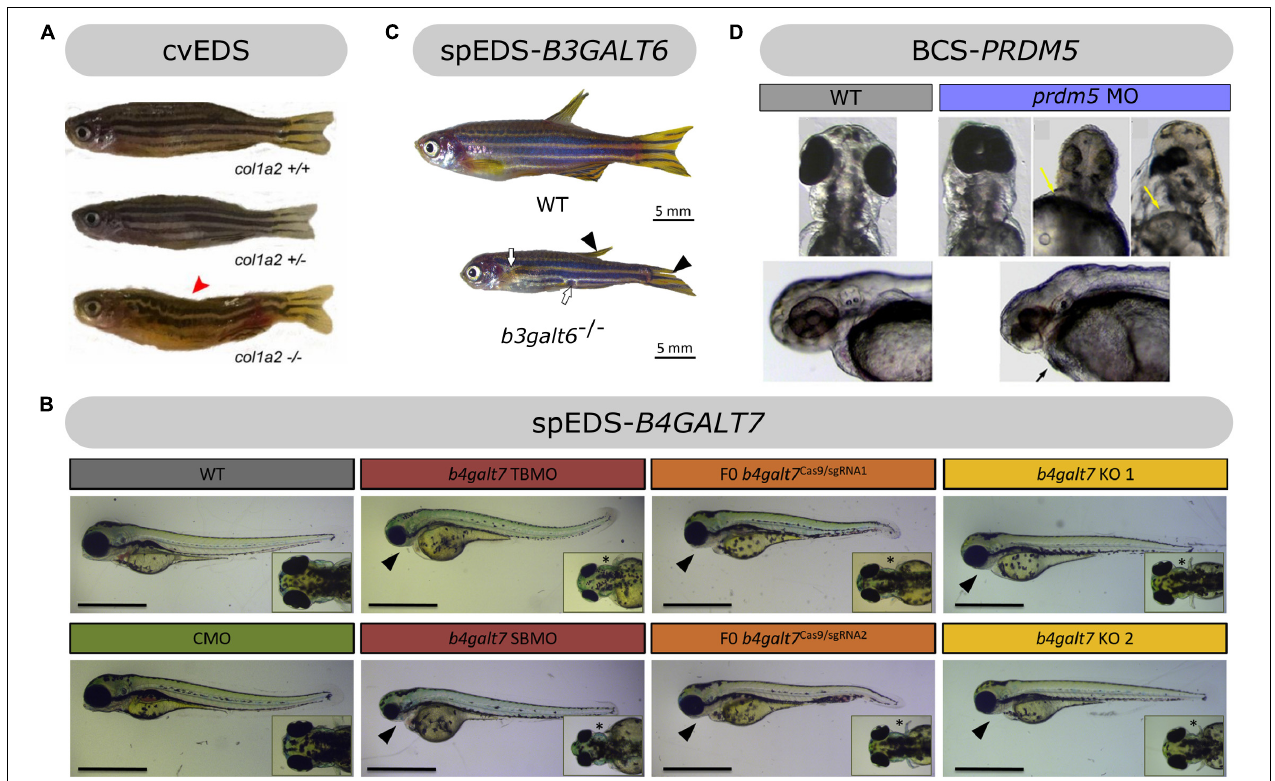
FIGURE 6 | Overview of the phenotypic findings in zebrafish models of EDS. (A) Adult col1a2 − / − zebrafish model of cvEDS. Images adapted from Gistelinck et al. (2018). (B) Larval b4galt7 morphant, crispant and knockout models of spEDS- B4GALT7 . Scale bars: 1 mm. Images adapted from Delbaere et al. (2019a). (C) Adult b3galt6 − / − zebrafish model of spEDS- B3GALT6 . Images adapted from Delbaere et al. (2020). (D) Morpholino (MO)-based knockdown of prdm5 in zebrafish larvae. Images adapted from Meani et al. (2009). Images depicted in (A,C,D) were used under the Creative Commons License and image B with license number